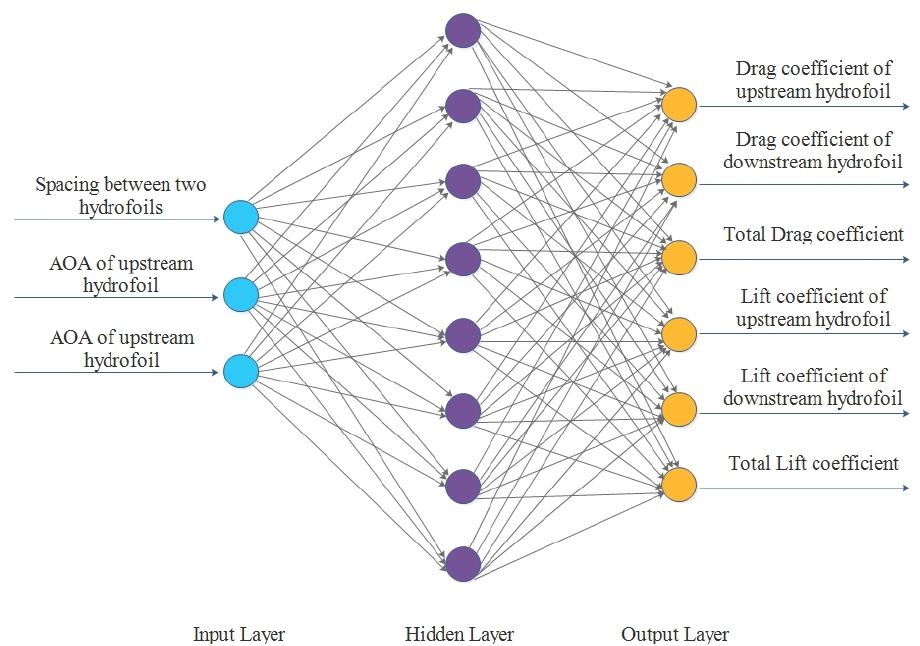
Figure 6. Neural network